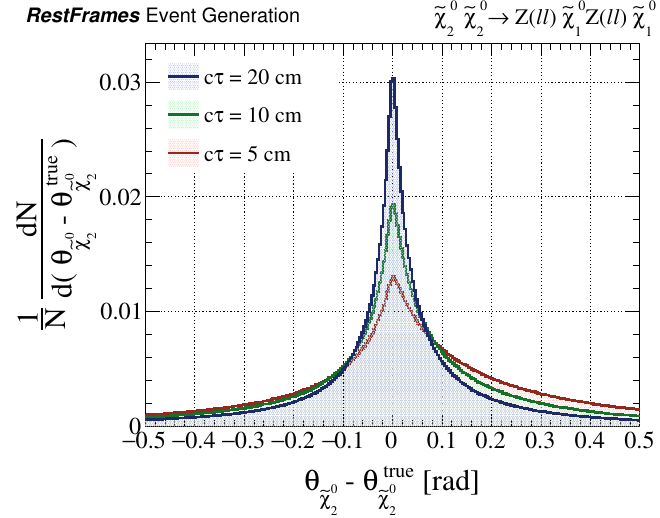
Figure 9 . The full-width-half-maximum (FWHM) of reconstructed mass distributions as a function of timing detector single-track resolution. (Left) Width of the LLP mass distribution accounting for combinations of di(cid:11)erent experimental uncertainties. (Right) Width of the LSP mass distribution for di(cid:11)erent LLP/LSP mass splittings. An LLP mass of 400 GeV and lifetime of 20 cm is assumed when simulating these events unless otherwise noted.